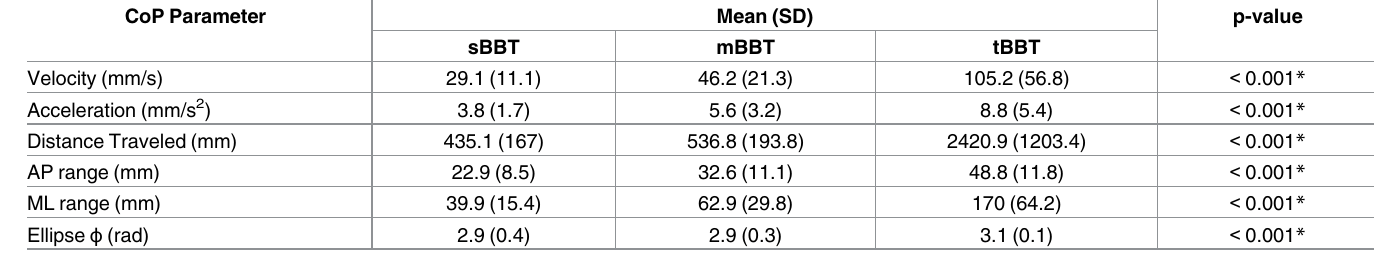
Table 1. CoP parametersfor each